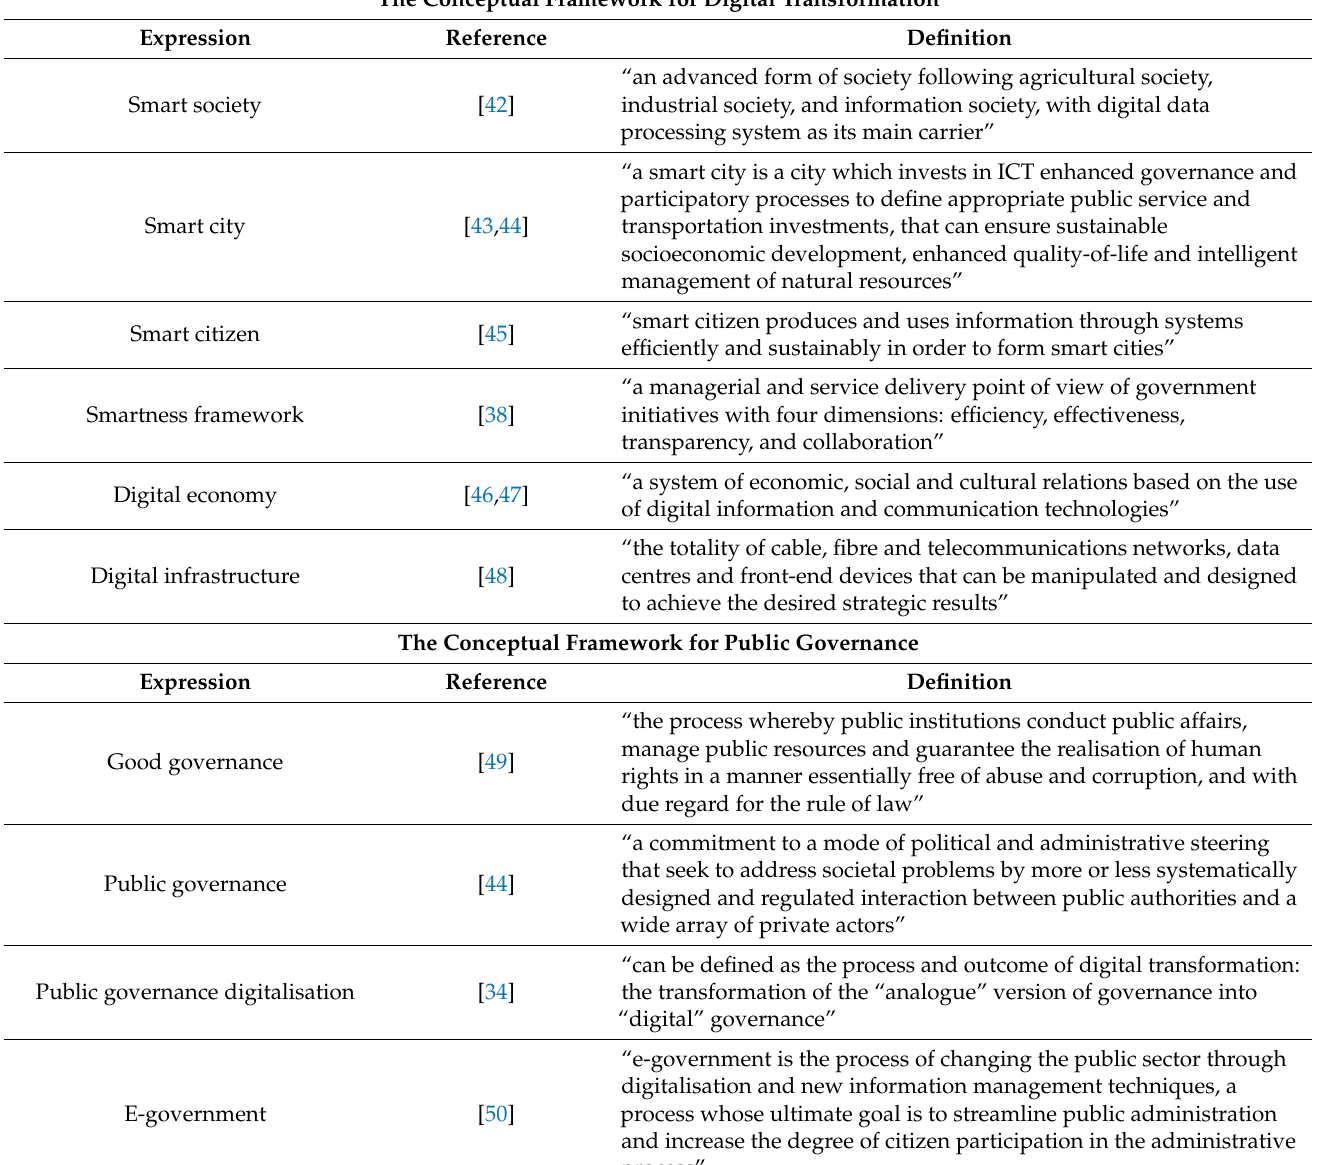
Table 1. Terms and expressions that form the theoretical framework specific to the process of digital transformation of public